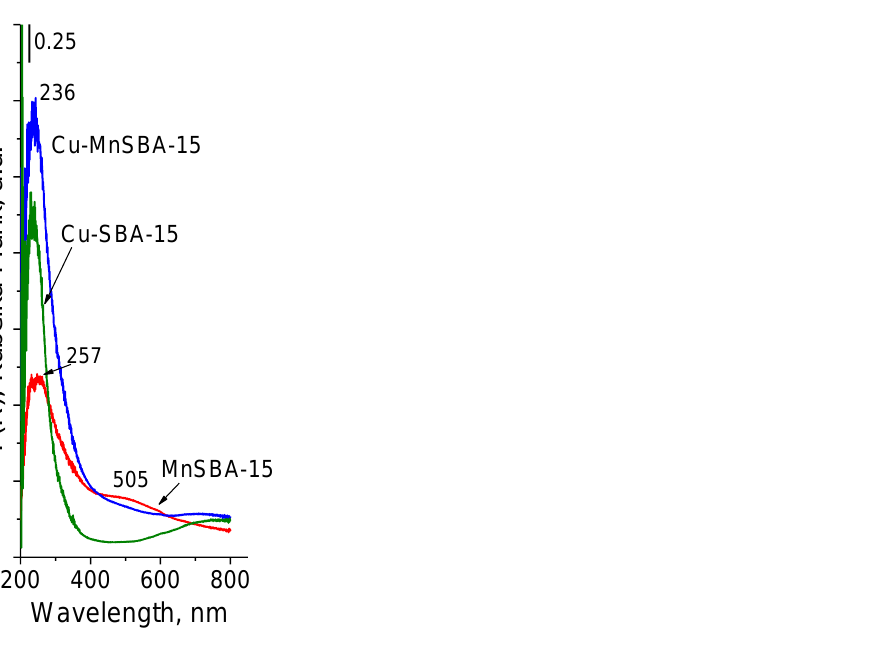
Figure 1. Uv-vis spectra of MnSBA-15 and copper-containing SBA-15 and MnSBA-15 materials. The spectrum of Cu-SBA-15 material shows a less intensive (because of the lack of the band coming from manganese species) band at 230 nm (from isolated cationic copper species (Cu 2+ )), and a band at ca. 750 nm characteristic of copper oxide (CuO) species. A slightly visible shift of the latter band to a lower wavelength in the spectrum of Cu-MnSBA- 15 suggests the interaction between CuO and manganese species. In order to get more insights into the surface composition and electronic state of the catalyst components, X-ray photoelectron spectroscopy was applied. All XP spectra were normalized to the binding energy (BE) of Si 2p = 103.4 eV. The Cu 2p 3/2 and Cu 2p 1/2 core level were employed to investigate the Cu surface oxidation and the XP spectra of Cu-SBA-15 and Cu-MnSBA-15 are shown in Figure 2. As reported in the literature [20,21], XPS peaks at 931–933 eV and 933.5–935.5 eV are typical of Cu 2p 3/2 core level of Cu + and Cu 2+ species, respectively. The binding energy gap between Cu 2p 3/2 and Cu 2p 1/2 core level should be ca. 20 eV. It is necessary to note that it is difficult to distinguish the Cu + ion from zero-valence copper by XPS, but Cu 2+ species can be easily identified by the presence of the satellite signals attributed to an electron transfer from a ligand orbital to the d orbital of the metal [22]. As shown in Figure 2, the binding energies in the Cu 2p 3/2 and Cu 2p 1/2 regions for Cu-SBA-15 are 934.0 eV and 953.7 eV, respectively. The position of the bands suggests the presence of Cu 2+ species, however, the absence of the satellite peaks at higher binding energies of ca. 9 eV excludes the presence of copper(II) oxide. It is possible that the valence state of Cu is between +1 and +2, as already mentioned in the literature [23]. The deconvolution of the XP spectrum of Cu-MnSBA-15 reveals two bands in the Cu 2p 3/2 region: at 933.2 eV and 934.9 eV. They are correlated with the bands in the Cu 2p 1/2 region (953.9 eV and 962.7 eV, respectively). The first pair of bands (933.2 eV and 953.9 eV) indicates the presence of copper species at a lower oxidation state. The binding energies are higher than reported in the literature for Cu 2 O [20,21]. The second pair of XP bands (934.9 eV and 953.9 eV) is correlated with the slight shake-up satellite peaks (ca. 944 eV and ca. 962 eV) and evidence of the presence